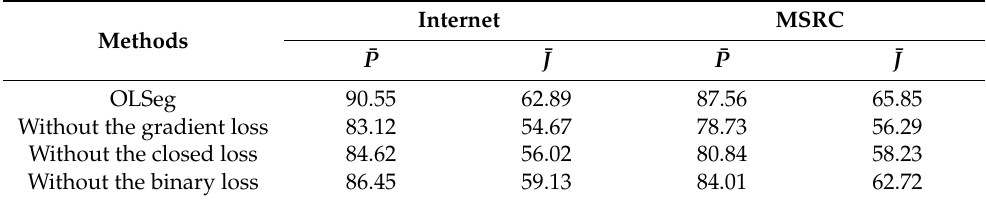
Table 5. Ablation study of OLSeg on the Internet and MSRC